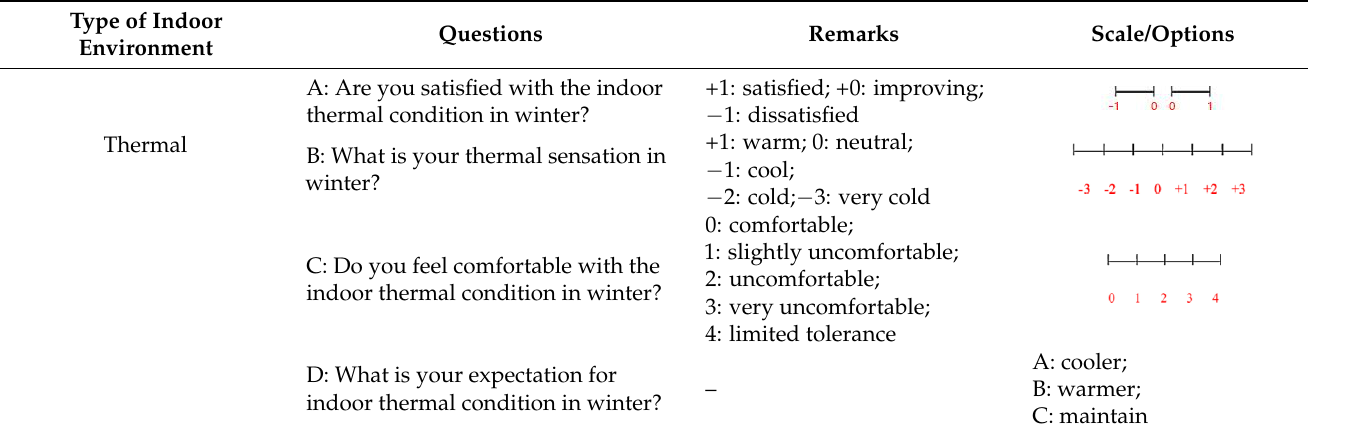
Table 2. Indoor environment survey.